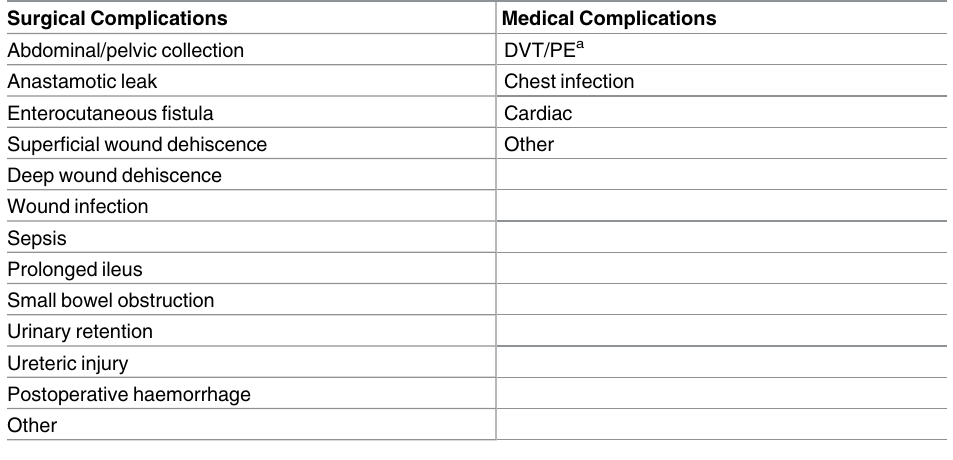
Table 8. List of Surgical and Medical